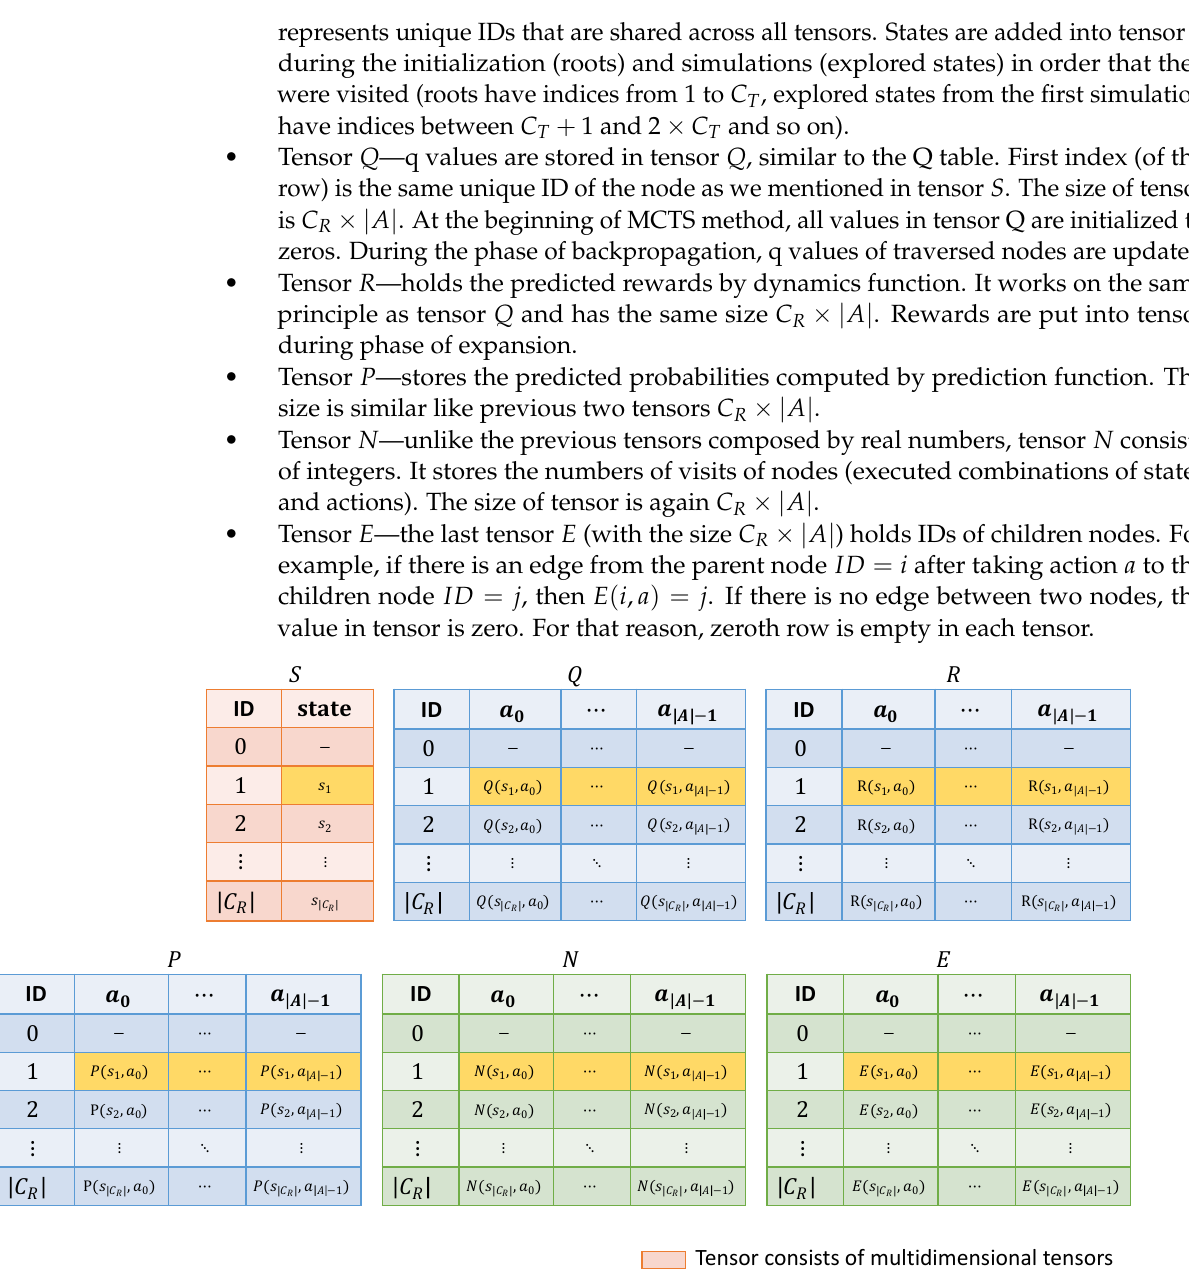
Figure 1. Data structure—the data of each node is stored in 6 tensors. IDs represent indices of nodes (they are not stored as tensor values). For example, the highlighted rows represent all stored data of a node with ID =